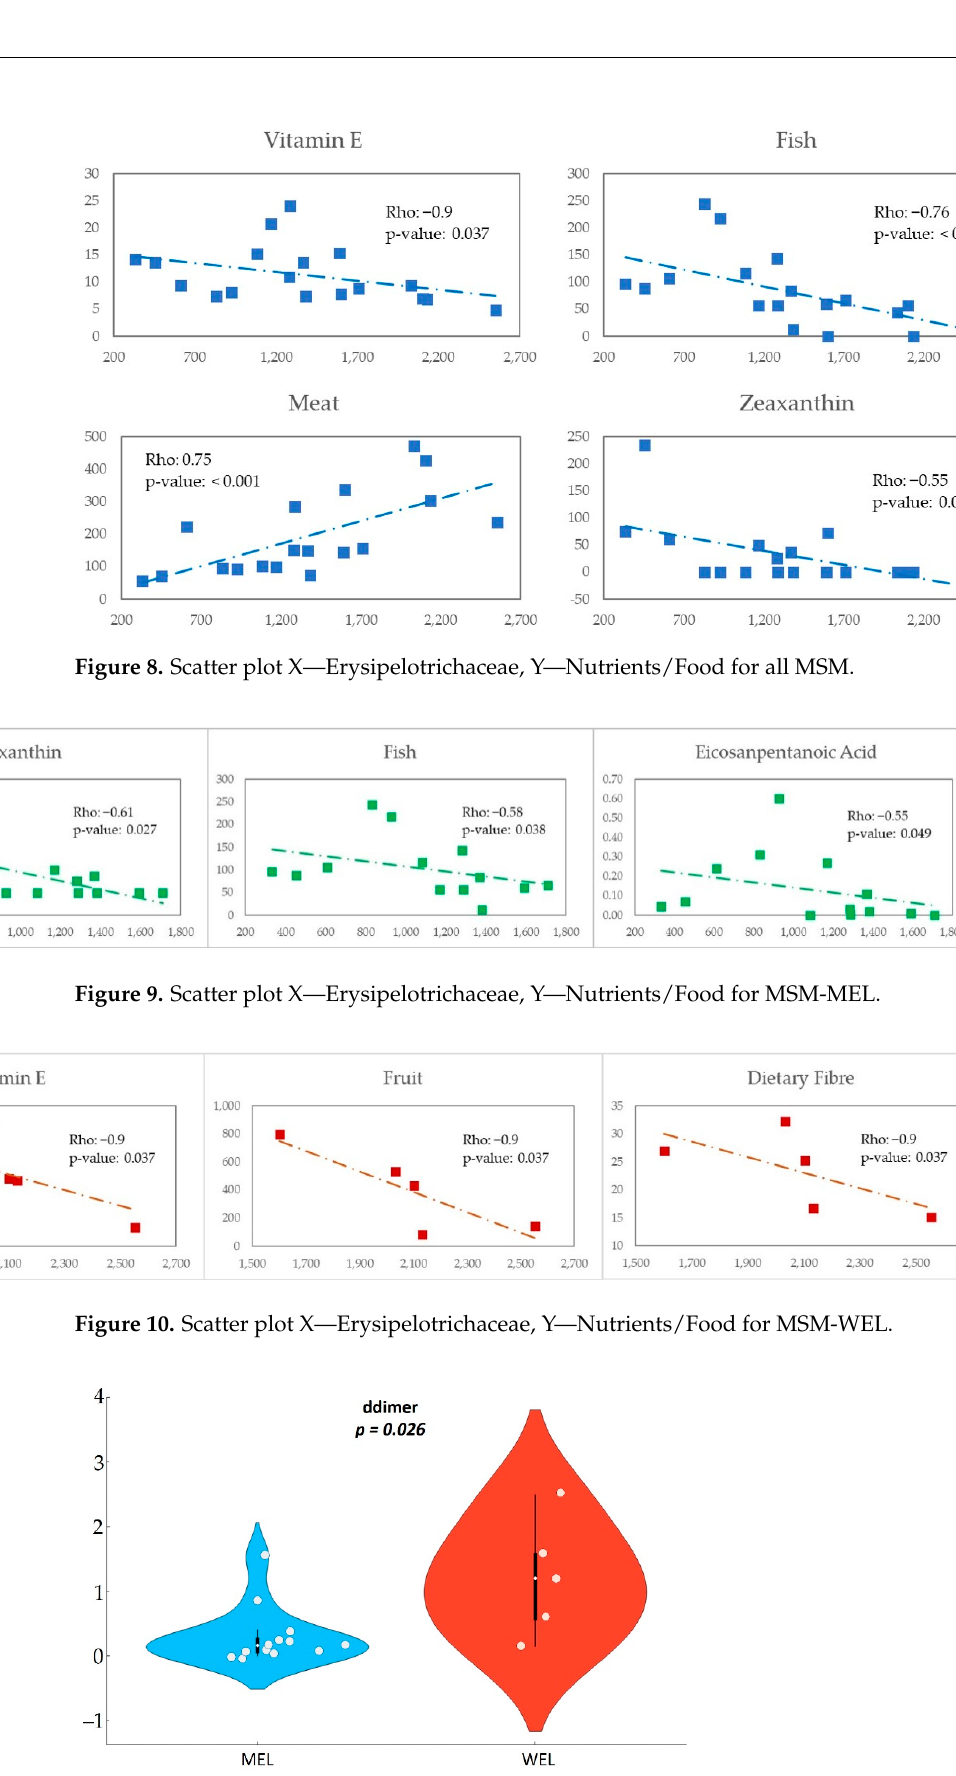
Figure 11. D-dimer biomarker in MSM by dietary